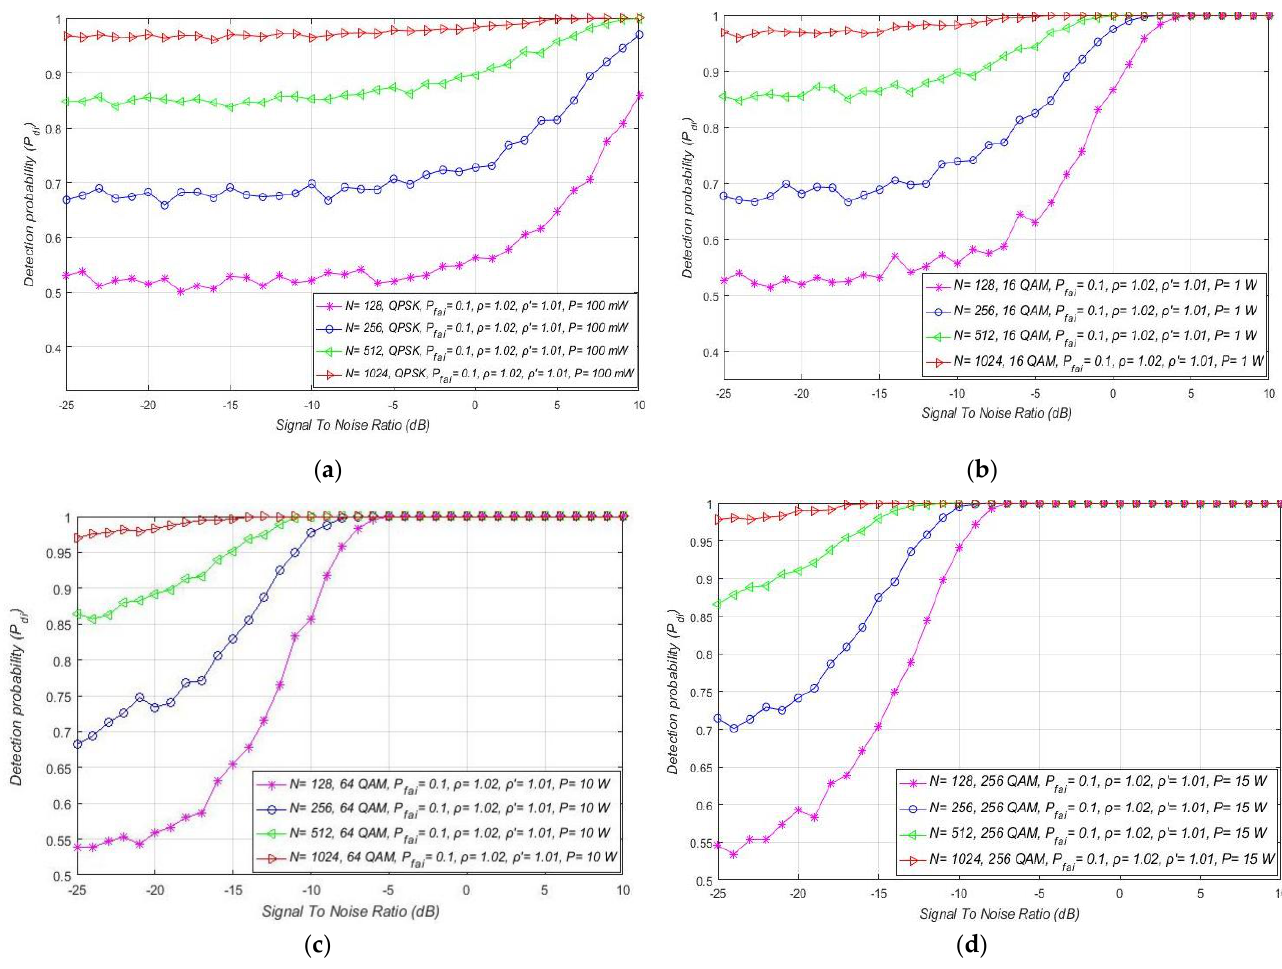
Figure 15. Influence of SNR and sample quantity on the detection probability in combined RA and MA systems transmitting at: ( a ) 0.1 W; ( b ) 1 W; ( c ) 10 W and ( d ) 15 W.